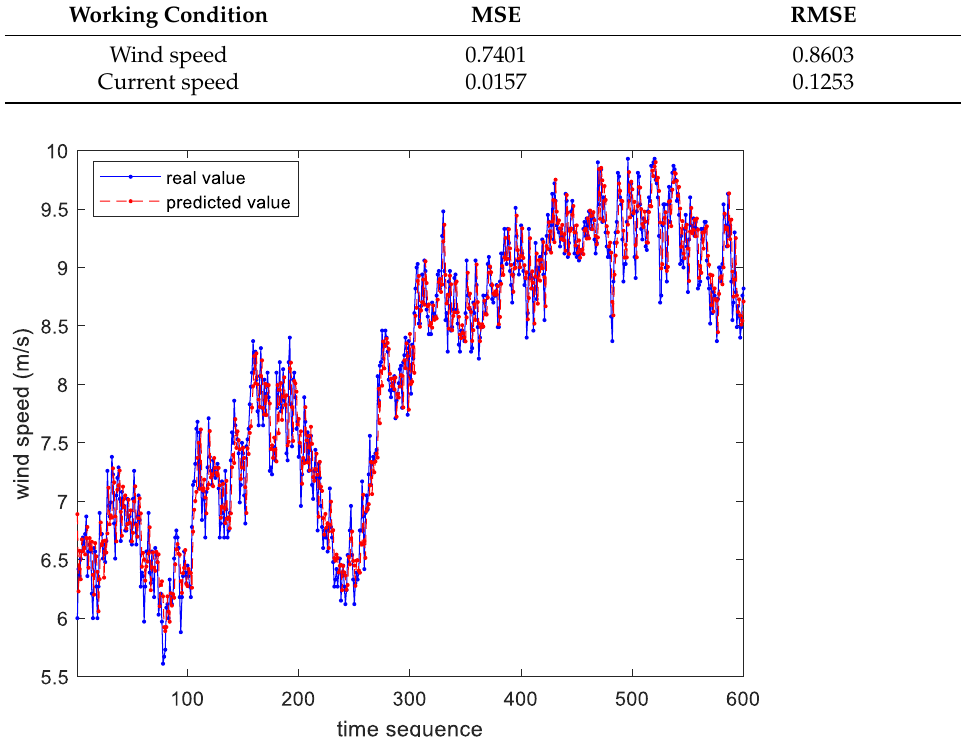
Figure 5. Prediction results of current speed.